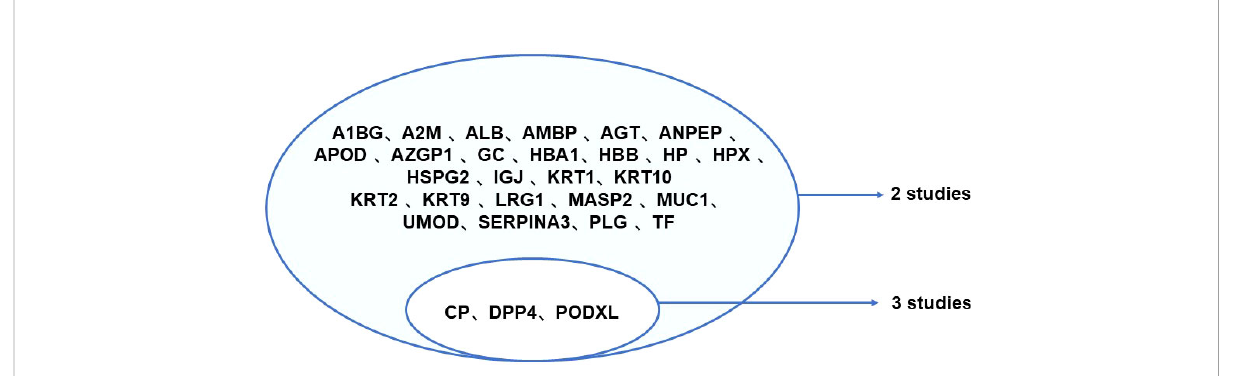
FIGURE 3 Replicability of urinary EV proteins detected in eligible studies. A1BG, Alpha-1-B Glycoprotein; A2M, Alpha-2-Macroglobulin; ADAM9, a disintegrin and a metalloprotease 9; ALB, Albumin; AMBP, Alpha-1-Microglobulin/Bikunin Precursor; ANPEP, Alanyl Aminopeptidase, Membrane; APOD, Apolipoprotein D; AZGP1, Alpha-2-Glycoprotein 1, Zinc- Binding; CP, ceruloplasmin; DPP4, dipeptidyl peptidase-IV; GC, guanylate cyclase; HBA1, Hemoglobin Subunit Alpha 1; HBB, Hemoglobin Subunit Beta; HP, haptoglobin; HPX, hemopexin; HSPG2, Heparan Sulfate Proteoglycan 2; IGJ, Immunoglobulin J; LRG1, Leucine Rich Alpha-2-Glycoprotein 1; MASP2, mannanbinding lectin serine protease 2; MUC1, mucins; PLG, Plasminogen; PODXL, Podocalyxin; SERPINA3, Serpin Family A Member 3; F, Transferrin; UMOD,